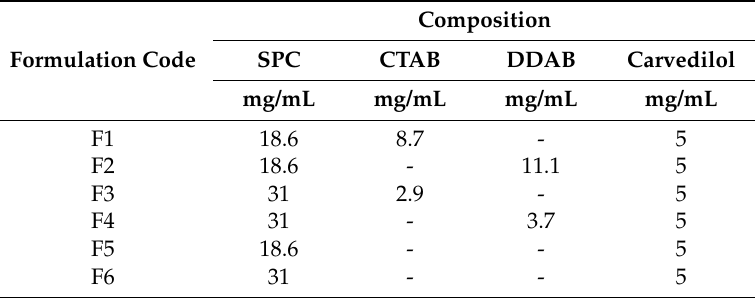
Table 1. Composition of leciplex formulae, n =